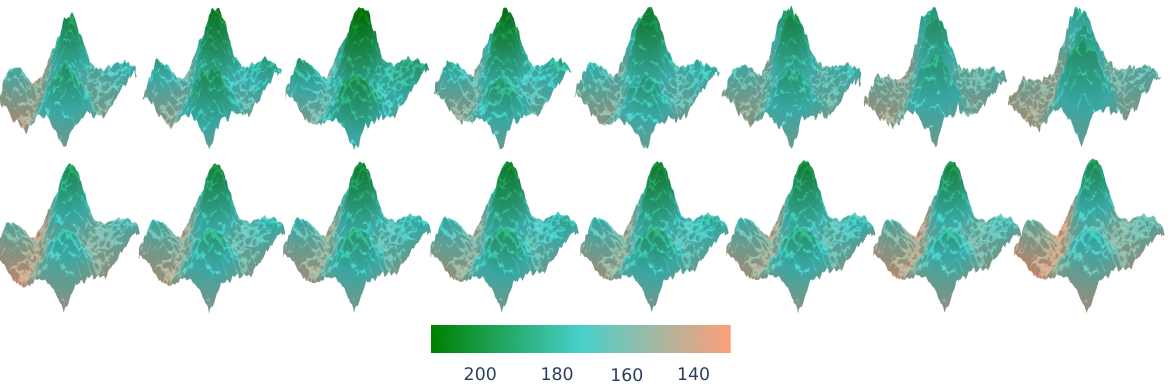
Figure 12. An example of 3D predicted pastures from the Gazebo simulated point cloud measurements for s = 4. ( Top ) Ground truth measured sward heights ( mm ) of the pasture. Left to right for a 60-day prediction horizon shown for every 8th day. ( Bottom ) Prediction by a δ = 32, s = 4